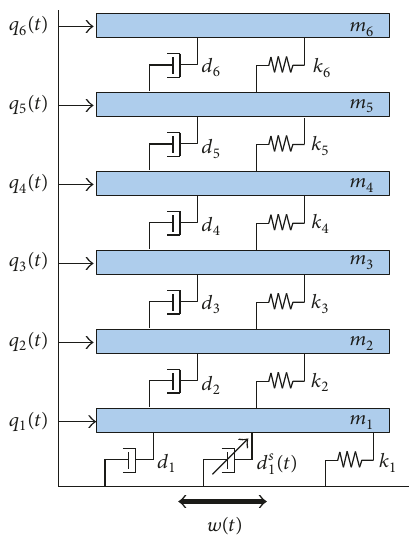
Figure 6: 6-DOF base-isolated structural system. Table 1: Structural parameters of the 6-DOF structural system.